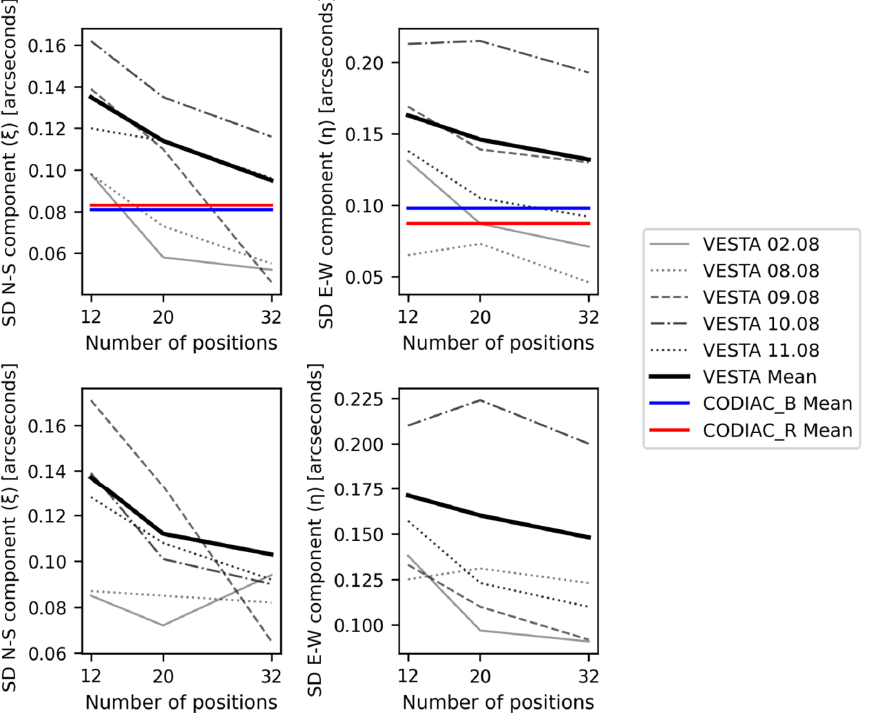
Figure 8. Change of VESTA SD in relation to number of VESTA measurement session positions. Top —SD for VESTA and CODIAC observed DoV values; bottom —SD of differences between CODIAC Blue and VESTA.